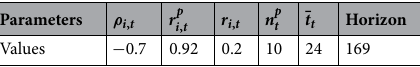
Table 2. Parameter values.